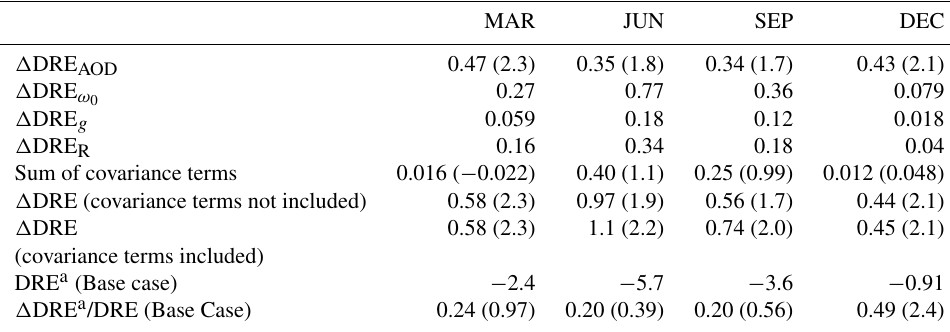
Table 4. Calculated measurement uncertainties in DRE at the TOA, using the sensitivities and correlations given in Table 3 and measurement uncertainties given in Table 2 as inputs to Eq. (8). Units of (cid:49) DRE are Wm − 2 . The uncertainties associated with aerosol optical depth are calculated twice: once using AERONET AOD uncertainties and once using the lower bound for MODIS AOD uncertainty (shown in